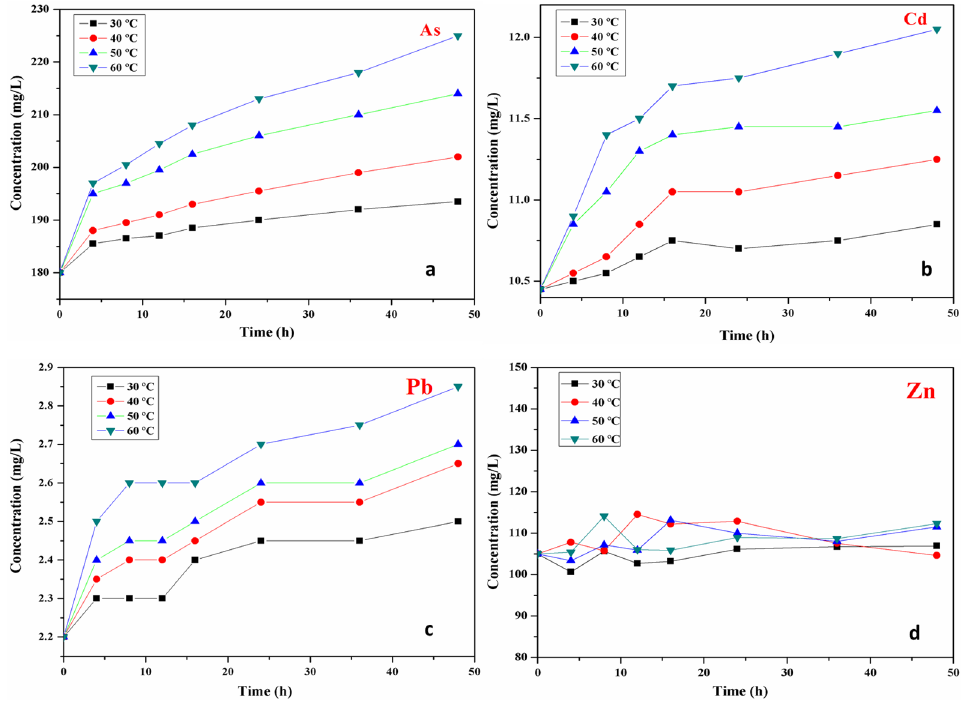
Figure 4. The release concentrations of arsenic ( a ) and heavy metals for the simulated condition: Cd ( b ), Pb ( c ), and Zn ( d ).